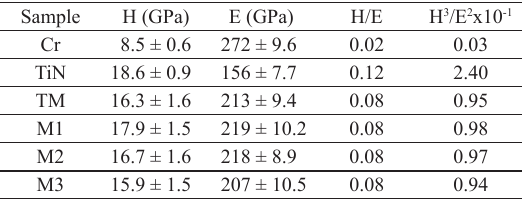
Table 1. H, E, H/E and H 3 /E 2 values of as deposited thin films.